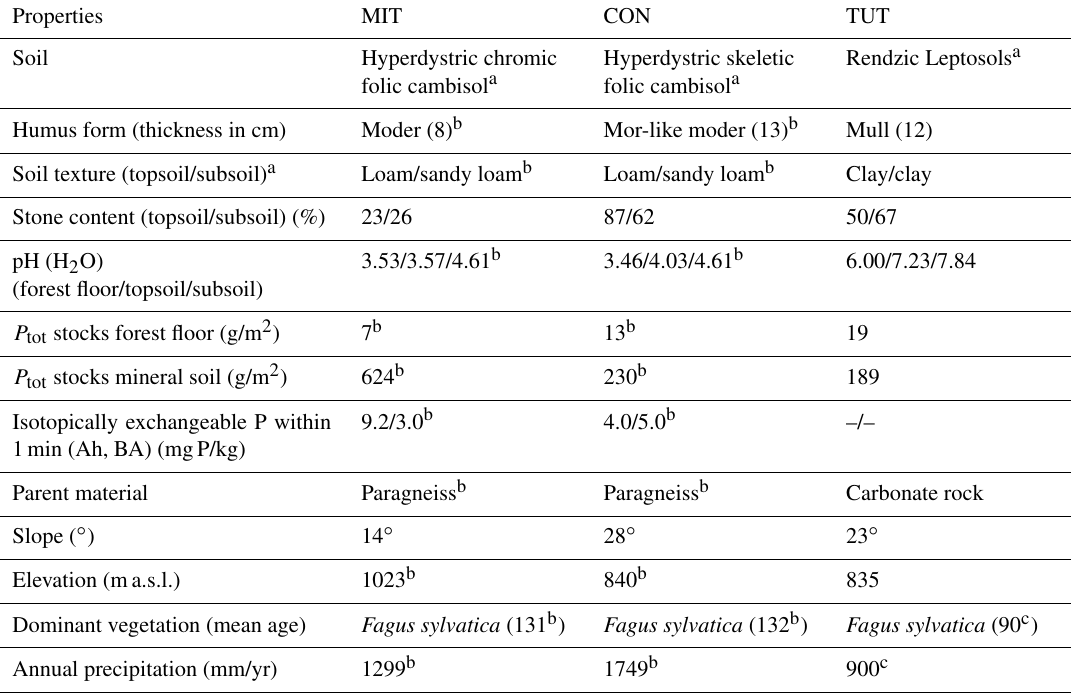
Table 1. Characteristics of the three experimental sites: Mitterfels (MIT), Conventwald (CON) and Tuttlingen (TUT). Properties MIT CON TUT Soil Humus form (thickness in cm) Soil texture (topsoil/subsoil) a